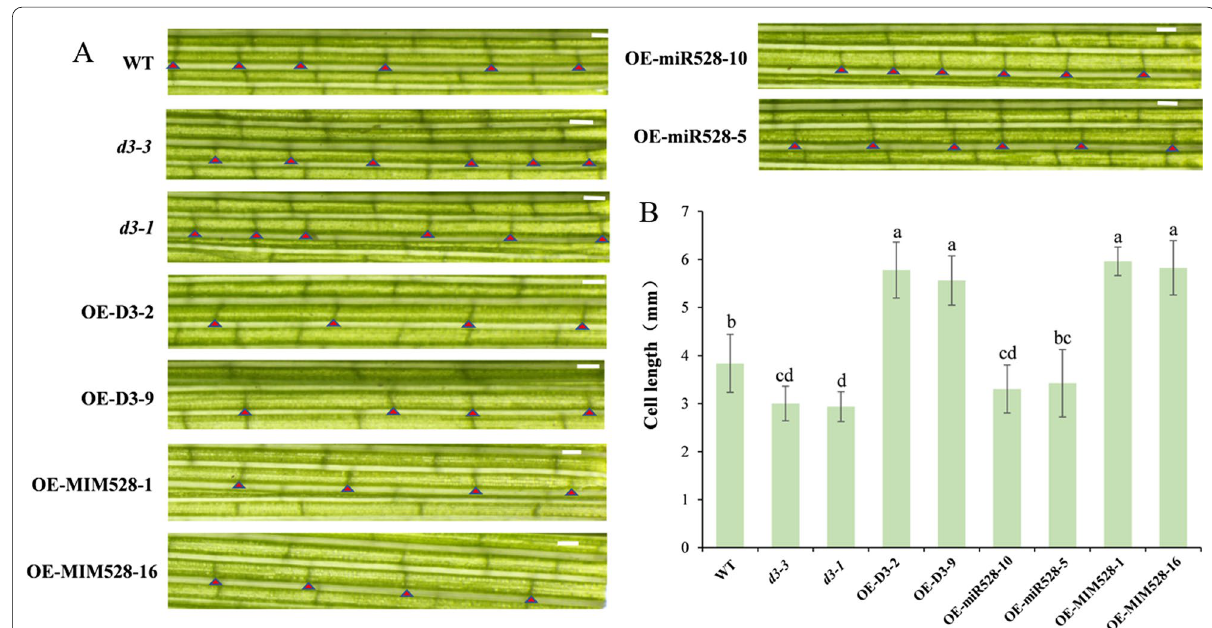
Fig. 3 Phenotypic analysis of the internode length of WT and transgenic lines. A Longitudinal section of the uppermost internode from WT and transgenic lines at the tillering stage. B Statistical analysis of the cell length of internodes in WT and transgenic plants. Data are shown as the means S.D. (n 10). Bars, 1 mm. Significant differences ( P < 0.05) are indicated by different letters ± =